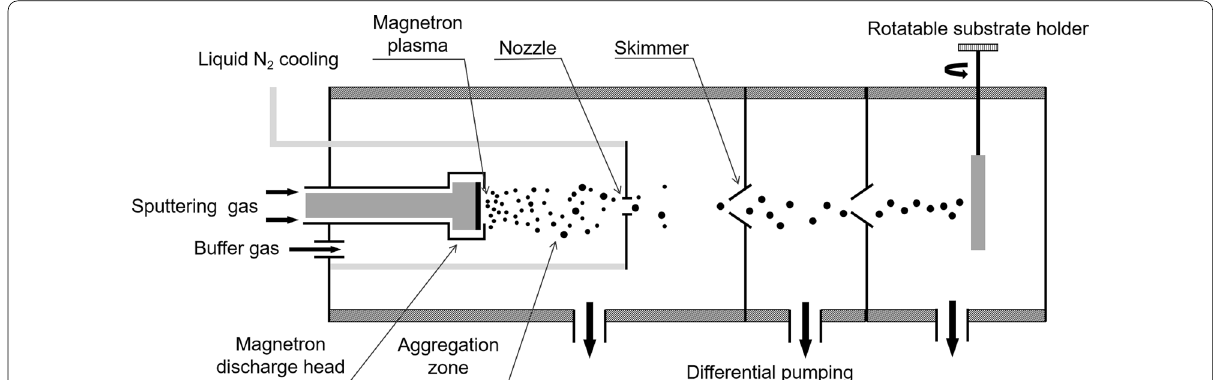
Fig. 1 Schematic diagram of a magnetron plasma gas aggregation cluster source and the cluster beam deposition process